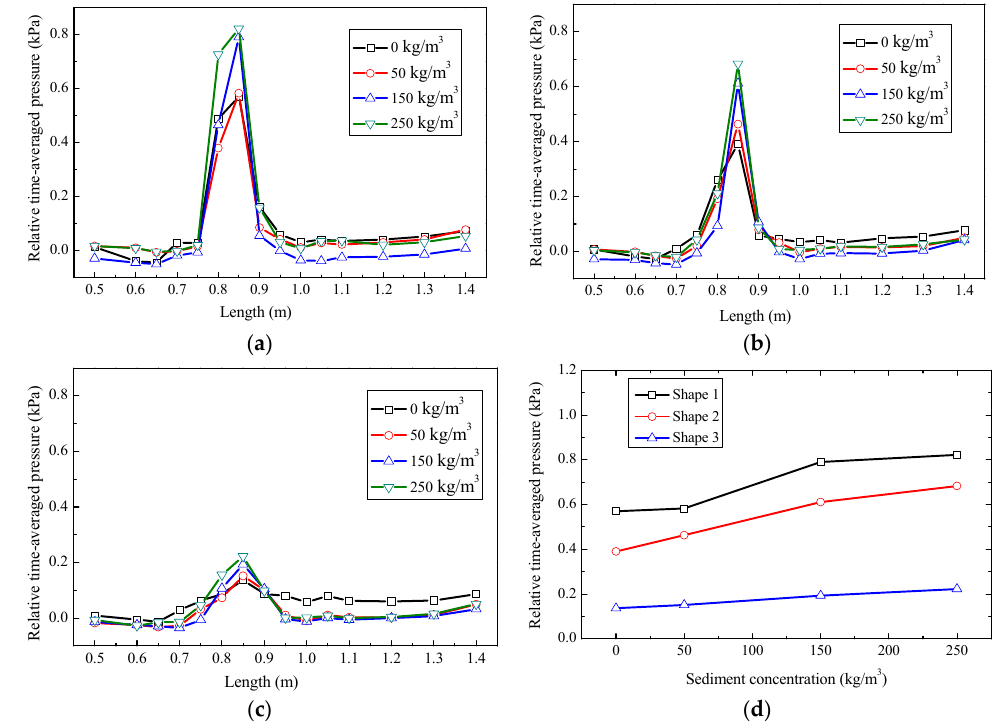
Figure 9. Relationship between the relative time-averaged pressure and sediment concentrations at various shapes; ( a ) shape 1; ( b ) shape 2; ( c ) shape 3; ( d ) pressure comparison for various sediment concentrations at the impact point.